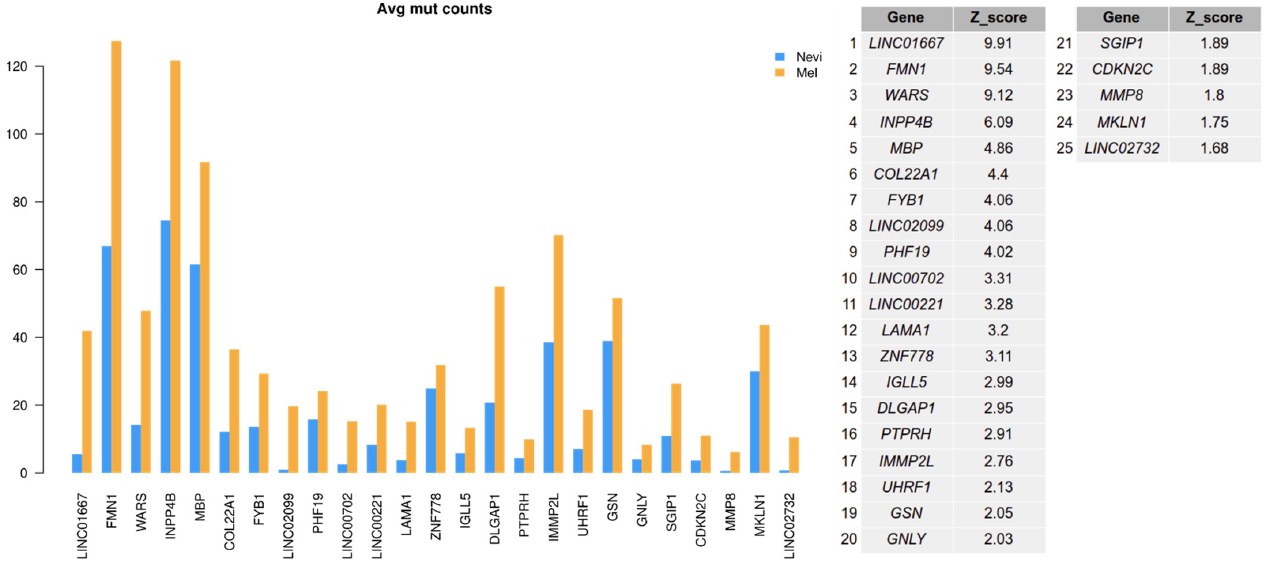
Figure 6. Number of mutations by gene in melanomas compared to benign melanocytic nevi. A mutation analysis was performed from the basic set of samples sequenced by RNA-seq. Only mutated genes of switched isoforms above a significance score (Z-score) of 1.6 with a 90% confidence interval are shown.